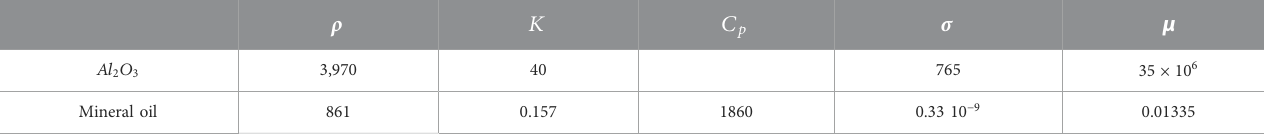
TABLE 1 Thermal properties associated with nanoparticles in base liquid (Hanif and Sha fi e, 2022; Wang et al.,